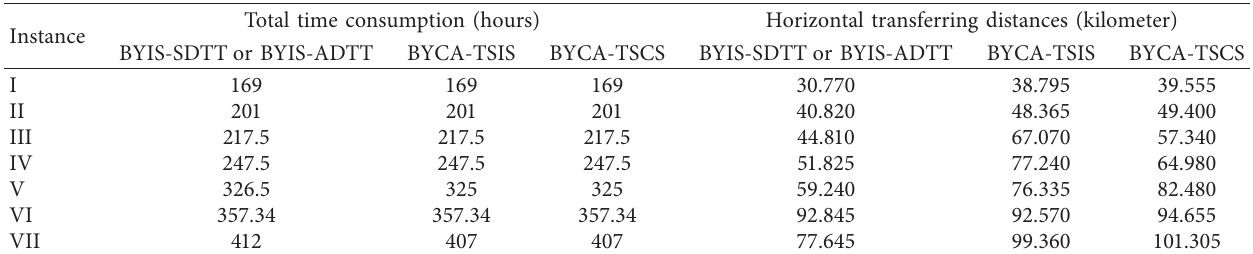
Figure 7: The number of vessels that occupy each block in four kinds of container zones. Table 11: The objective function values for BYIS-SDTT, BYIS-ADTT, BYCA-TSIS, and BYCA-TSCS.